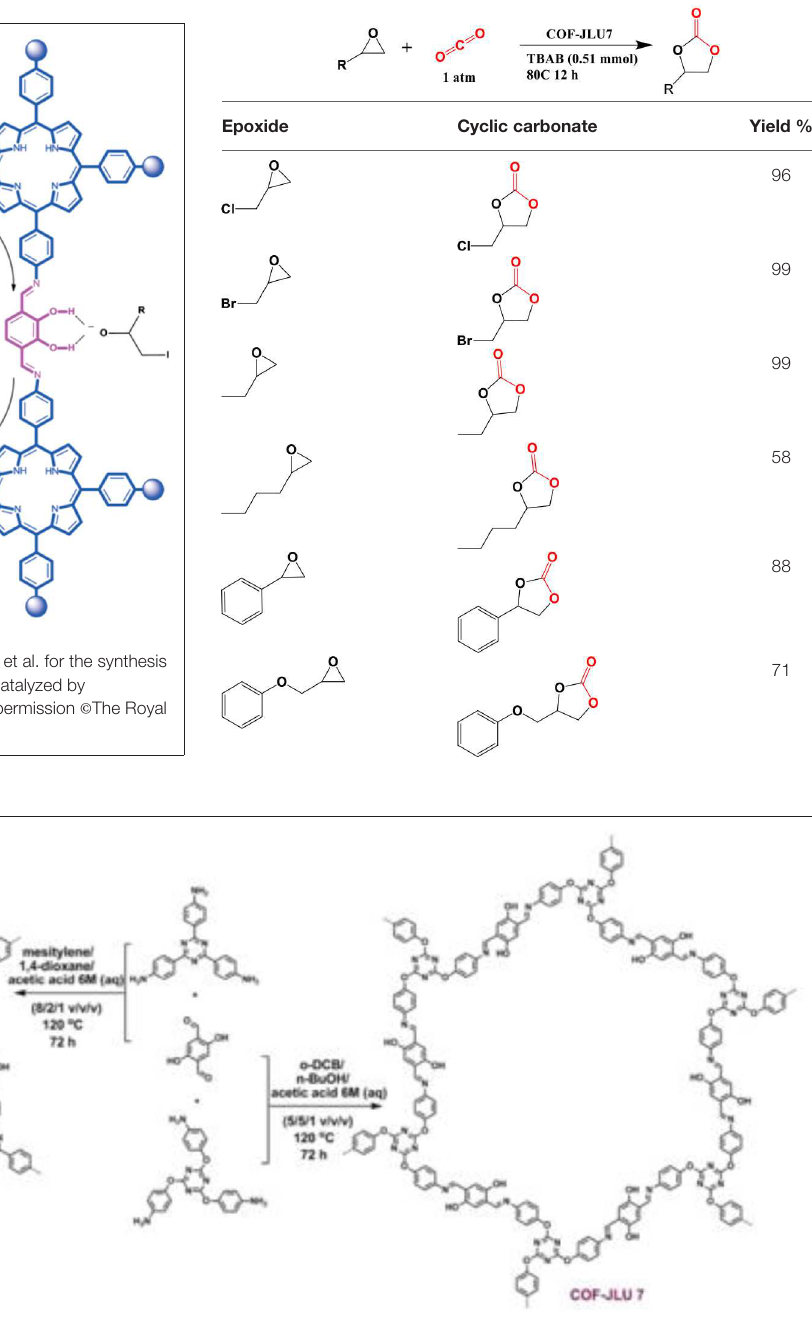
Frontiers in Energy Research |